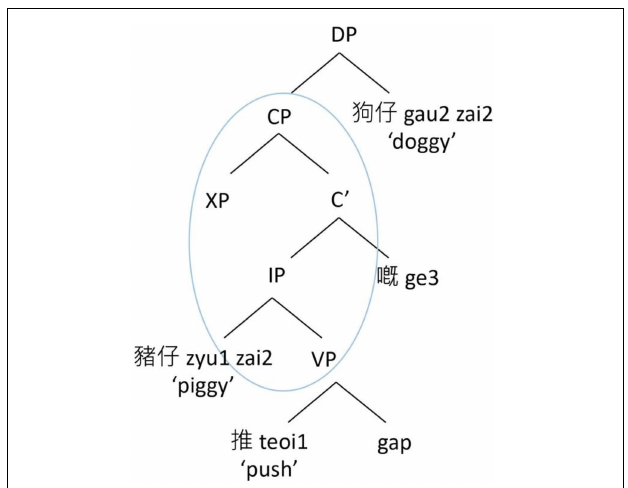
FIGURE 4 | Hierarchical structure of a Cantonese object